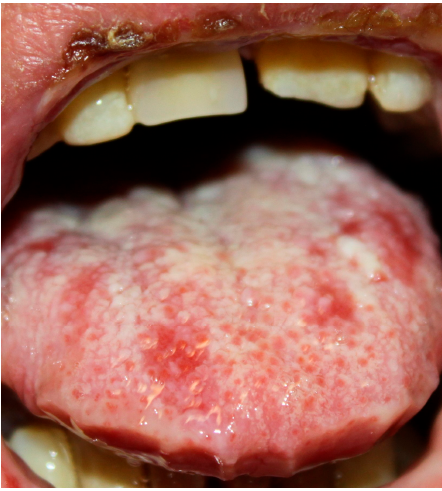
Figure 1. Paraneoplastic pemphigus (PNP) oral lesions . Ulceration involve oral mucosal surface and tongue. Stomatitis is also visible.